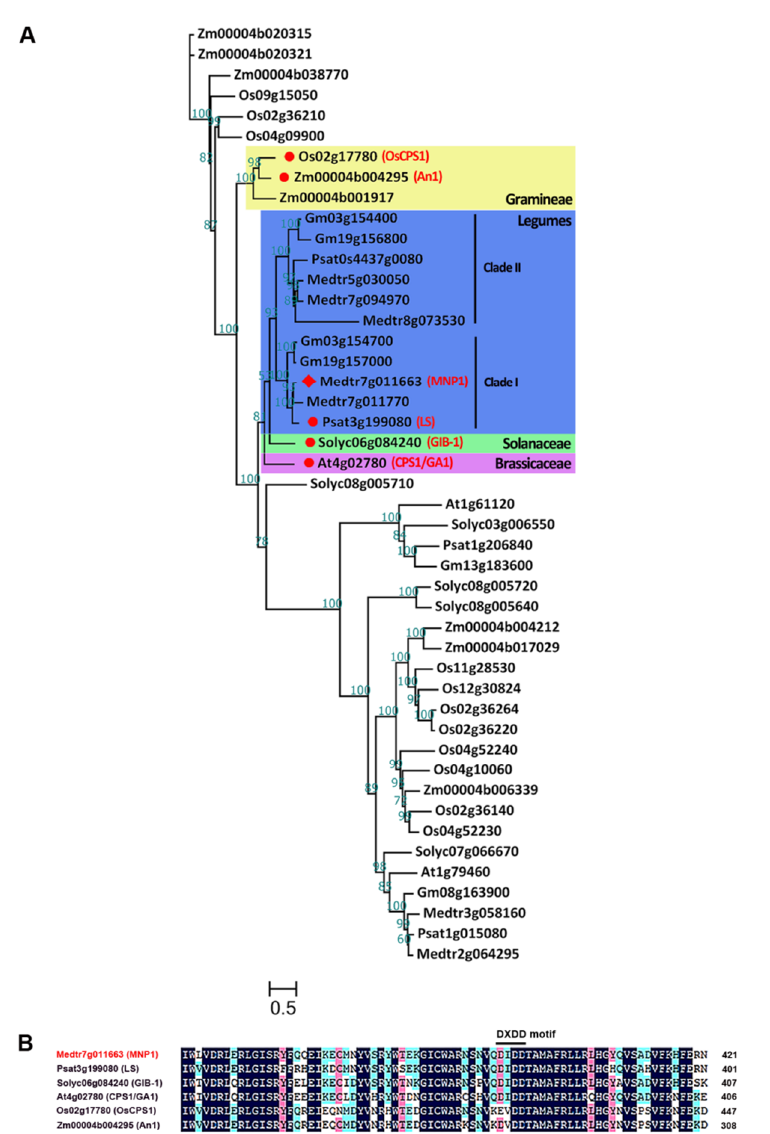
Figure 3. Phylogenetic analysis and sequences alignment of MNP1 and its closely related homologs. ( A ) Phylogenetic analysis of MNP1 and its homologs. Proteins from the species Medicago truncatula (Medtr), Pisum sativum (Psat), Glycine max (Gm), Solanum lycopersicum (Solyc), Arabidopsis thaliana (At), Oryza sativa (Os) and Zea mays (Zm). Bootstrap values are indicated upon the branches. Red rhombus indicates MNP1 protein and red circles indicate the reported CPS proteins. ( B ) The sequences alignment of MNP1 and the reported CPS proteins. The amino acid color indicates the homology of sequences between these species: black = 100%, pink ≥ 75% and blue ≥ 50%. The DXDD motifs in the sequences are indicated by the black line.